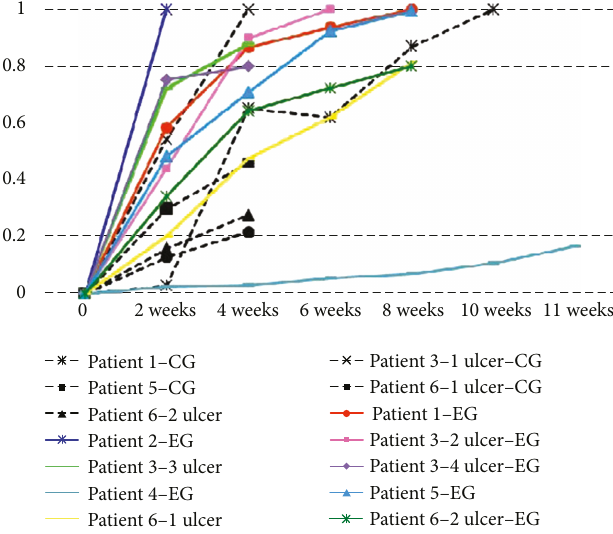
Figure 8: Evolution of the Ulcer Healing Rates (UHRs) in relation to the treatment time (in weeks) for the control group (CG) and the experimental group (EG). This fi gure is reproduced from Reis [42], public